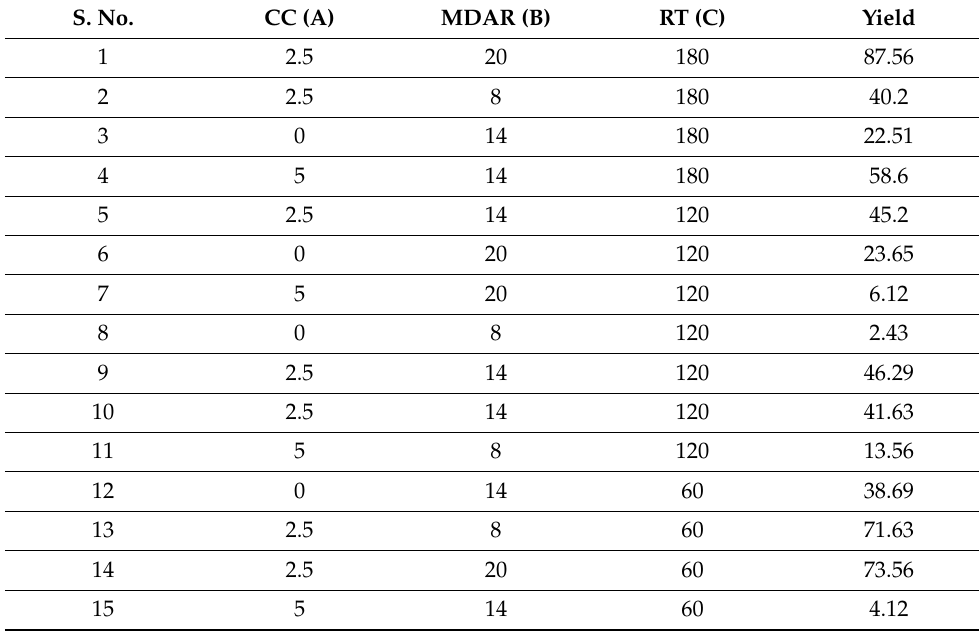
Table 5. Responses for transesterification of the blend (waste cooking oil + algae